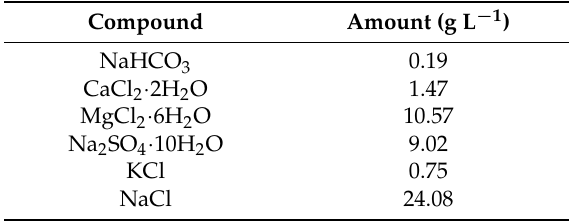
Figure 3. Schematic showing the setup used to test the bio-functionality of the bacteria-based beads. The setup consisted of: an insulated tank, oxygen microsensor, and water cooler. The tank was made up of an experiment chamber containing an artificial marine concrete crack solution (AMCCS) and cooling chamber containing freshwater. A cooling tube attached to a water cooler was used to cool the water of the cooling chamber, which was in turn used to cool the AMCCS of the experiment chamber to 8 ◦ C. Specimens were submerged in the AMCCS of the experiment chamber, and oxygen measurements made with a microsensor mounted to a motorized micromanipulator. Table 1. Composition of the artificial seawater based on the major constituents of natural seawater [19].